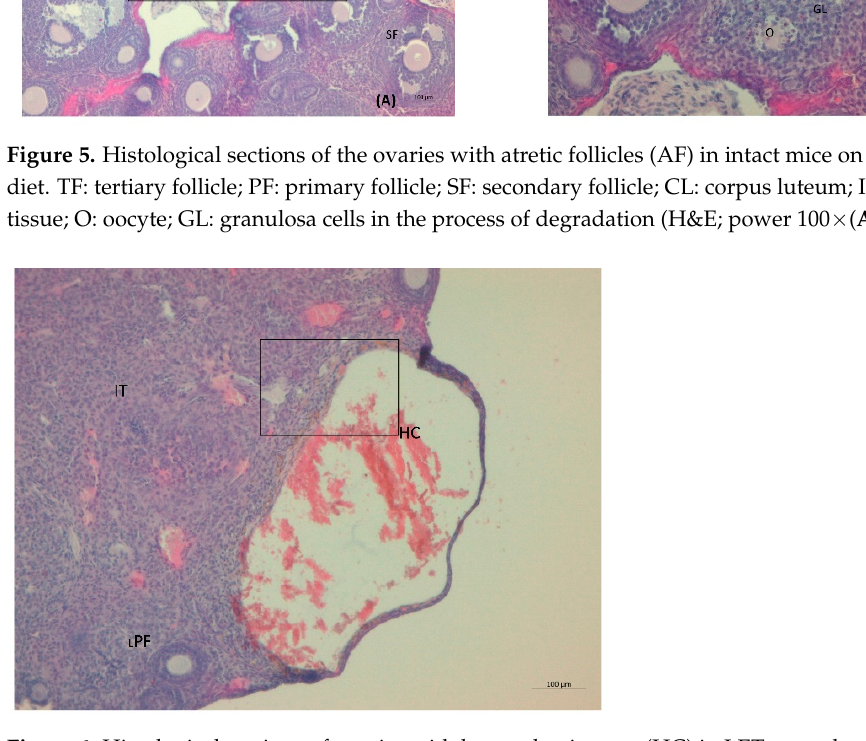
Figure 6. Histological sections of ovaries with hemorrhagic cysts (HC) in LET-treated mice. LPF: late primary follicle; IT: interstitial tissue (H&E; power 100×).